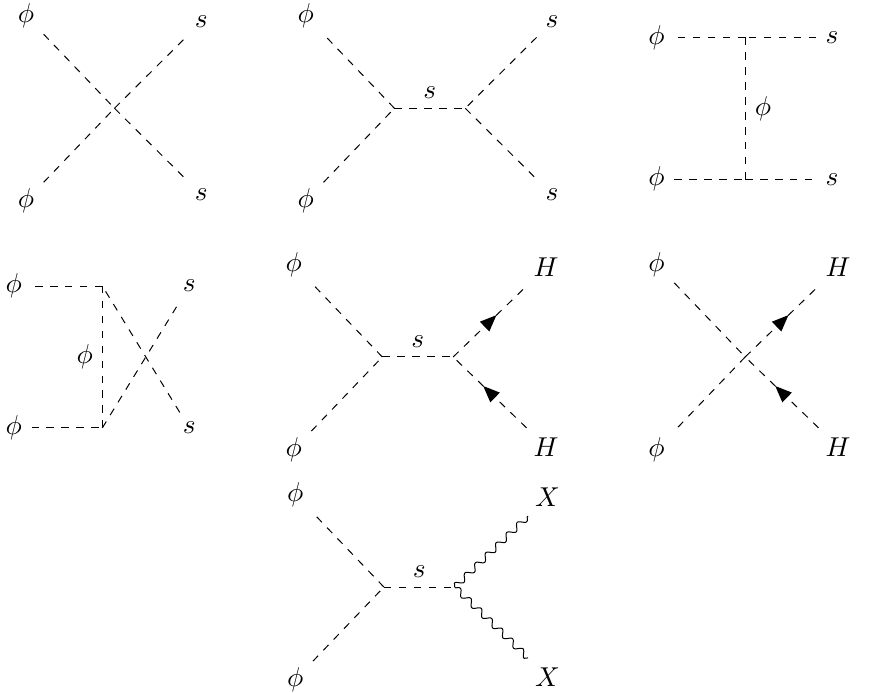
Figure 5 . Feynman diagrams contributing to φ freeze-out via 2 → 2 depletion processes